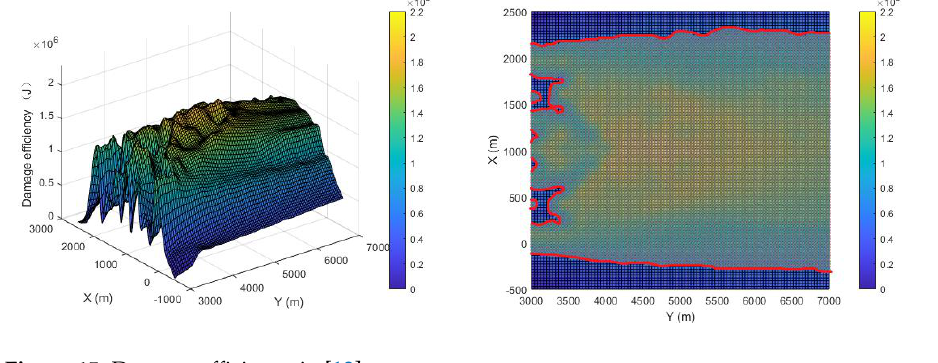
Figure 15. Damage efficiency in [13].